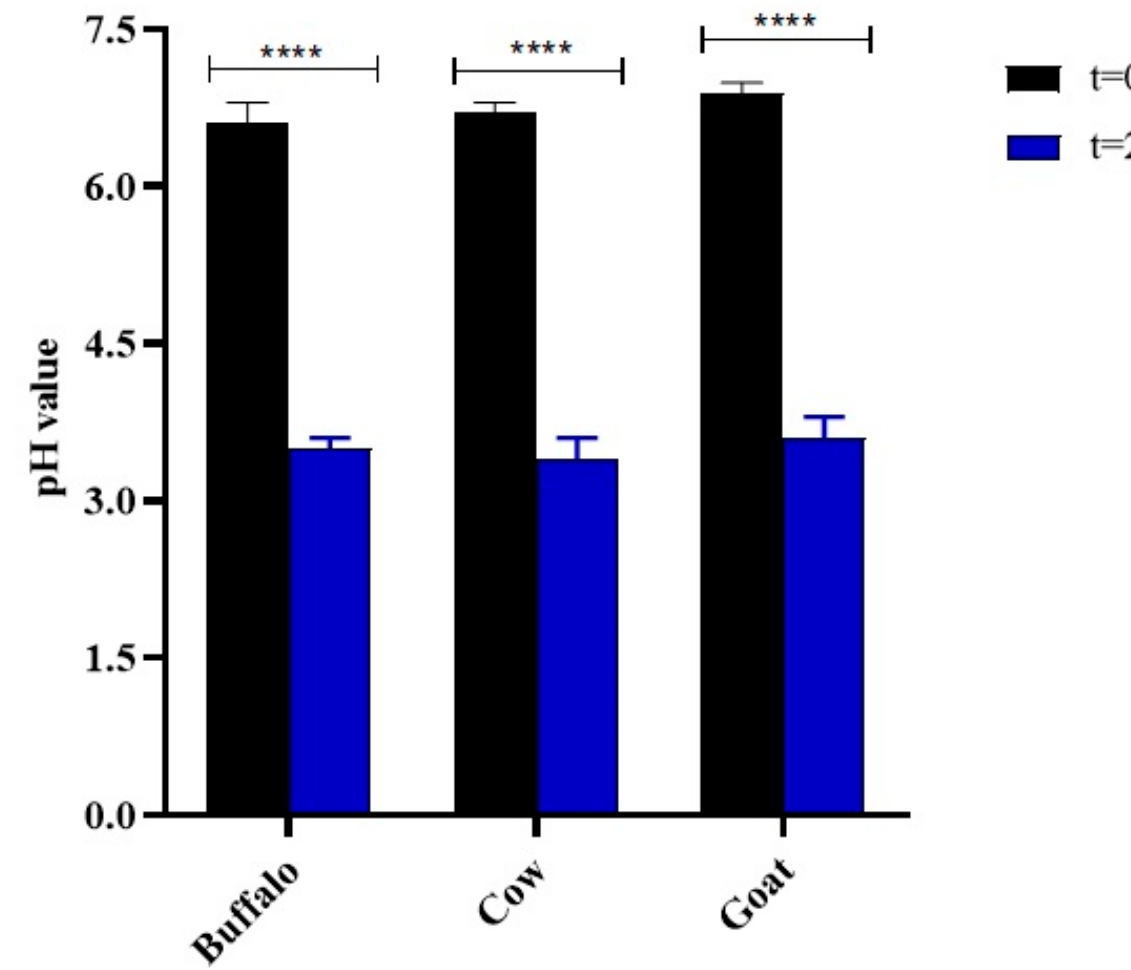
Figure 1. pH values of the samples at 0 h and 24 h of fermentation and their relative significance. Histograms and error bars represent the means of three independent experiments and standard deviations, respectively. Asterisks on bars indicated that the mean values were statistically different from time zero (**** p < 0.0001).